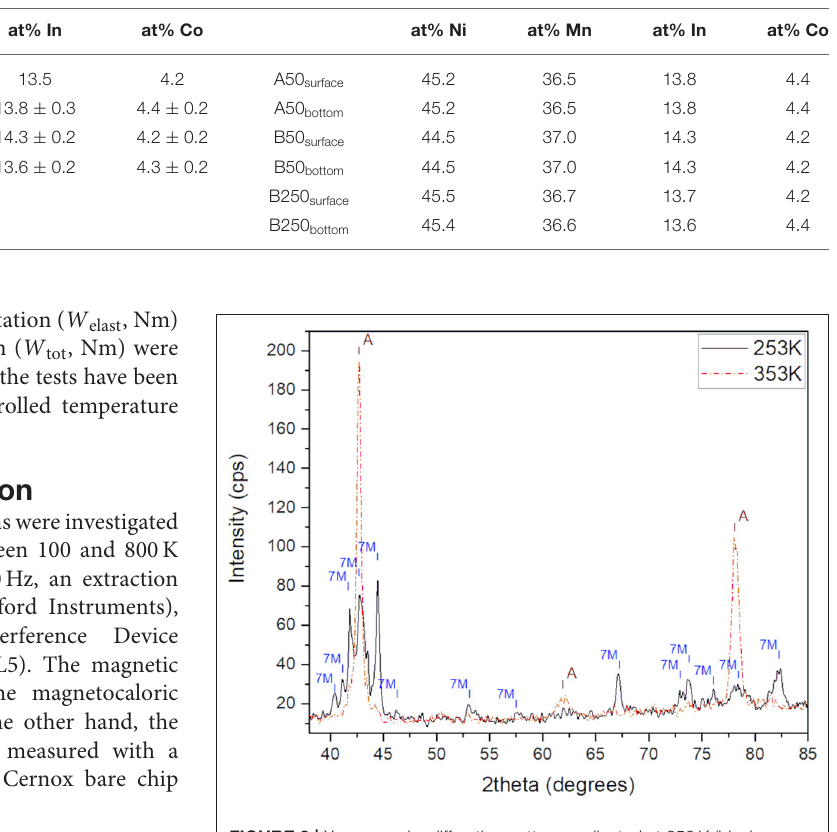
FIGURE 2 | X-ray powder diffraction patterns collected at 253K (black continuous line) and 353K (red dashed line). The peaks belonging to the martensitic and austenitic phases have been labeled for